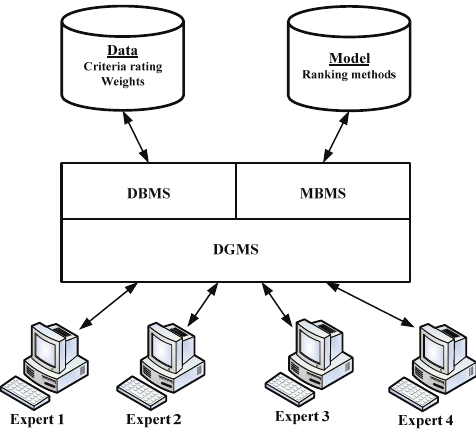
Fig. 4. The architecture of the IFSMDS.